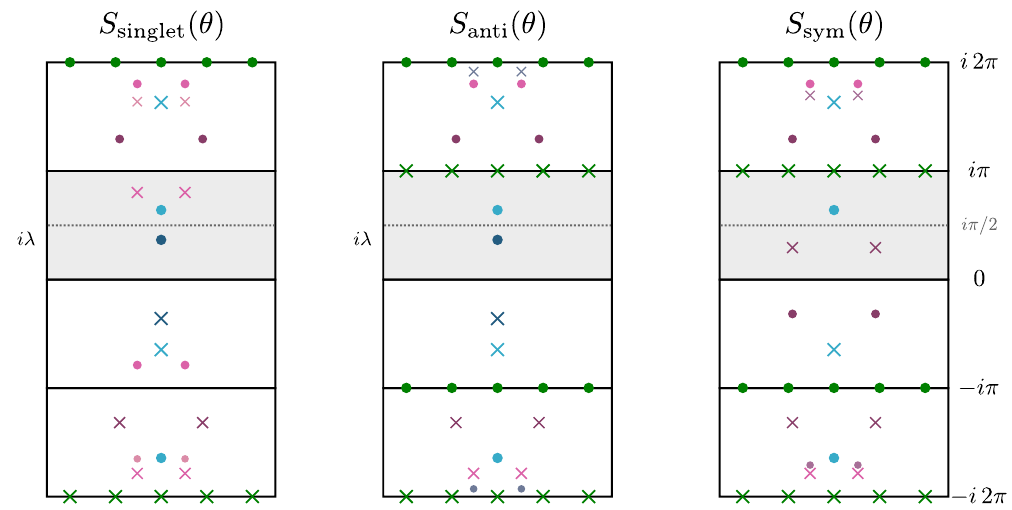
Figure 17 . Sketch of the analytic structure of more exotic S-matrices found by considering bound states in the singlet and anti-symmetric representations with m sing = m anti < m GN and maximizing the anti-symmetric coupling g anti